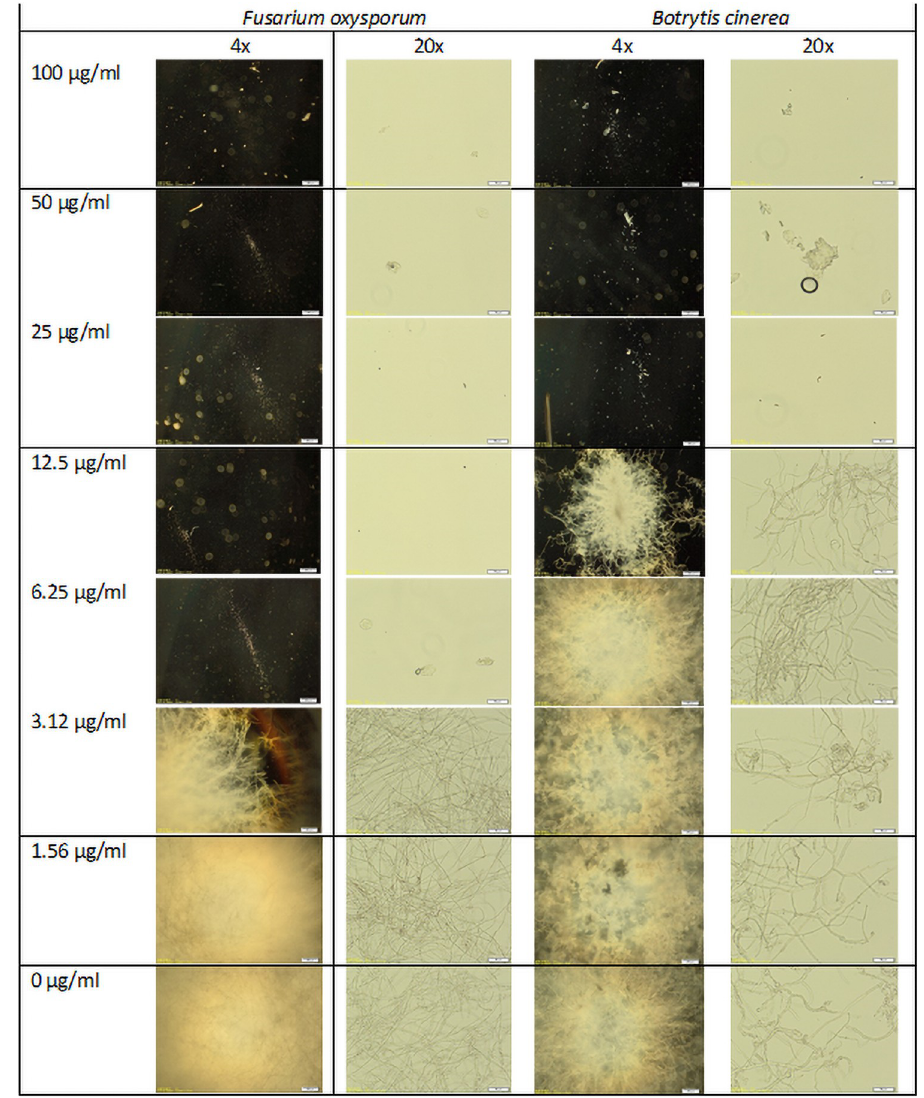
Fig 7. Representative pictures taken from the microtiter plate wells of antimicrobial assays for B . cinerea and F . oxysporum